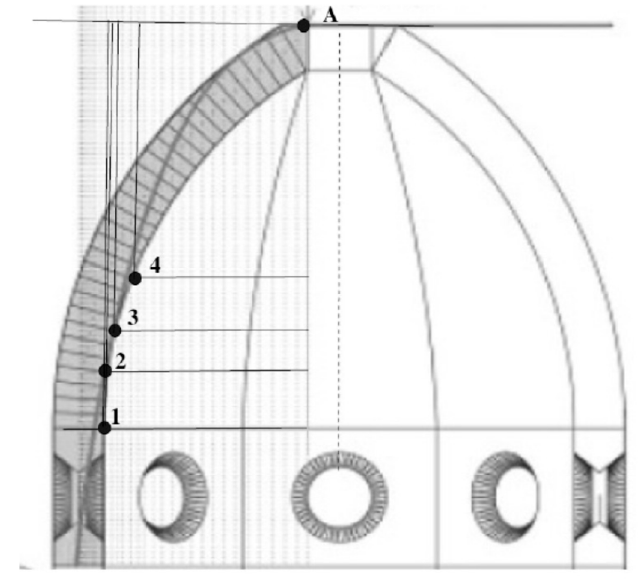
Figure 9. The section of Brunelleschi’s Dome with the positions 1, 2, 3, 4 of the considered internal hinge O of the various chosen settlement mechanisms. Table 1. Weight of voussoirs and coordinates of their